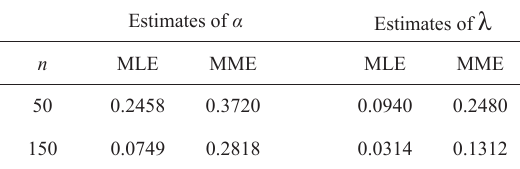
Integrated relative bias squared norm.